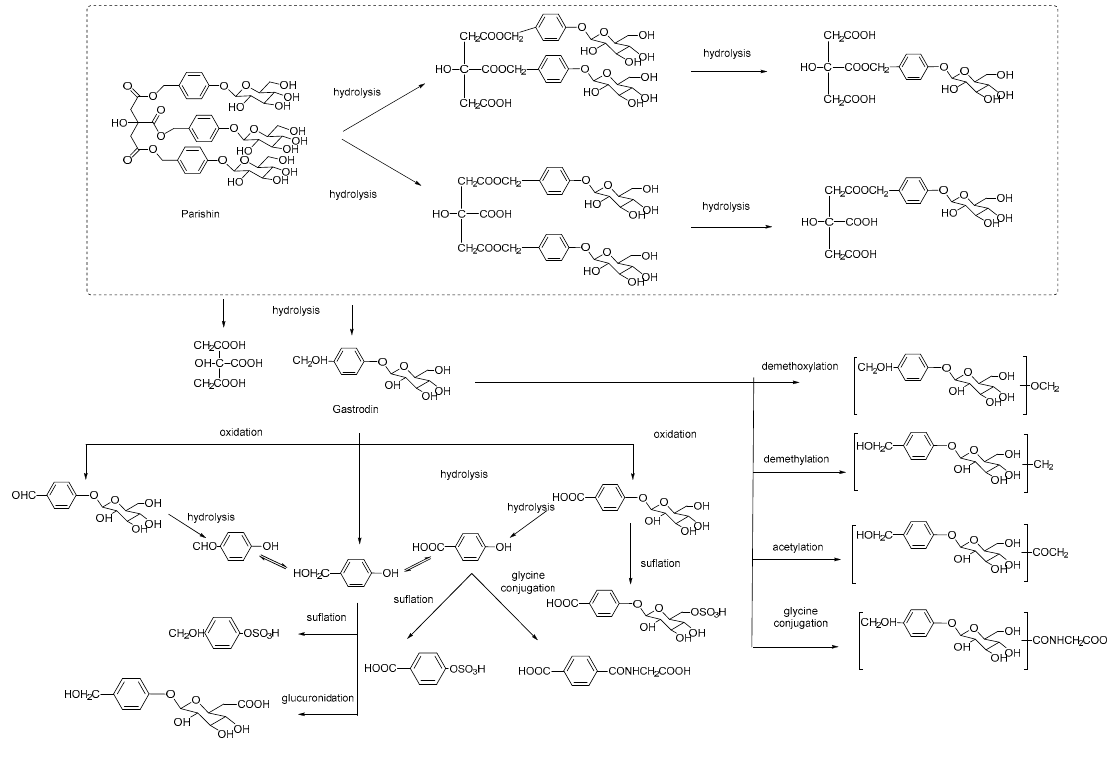
Scheme 1. The metabolic pathways of phenolics from G. elata